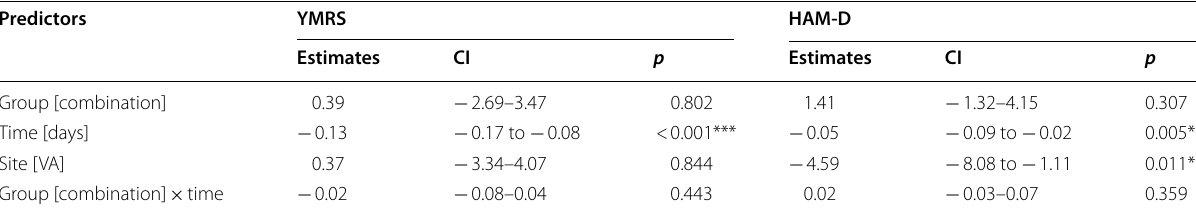
Monotherapy: divalproex plus placebo; combination: combination therapy of divalproex plus blinded lithium and divalproex plus blinded quetiapine VA Palo Alto